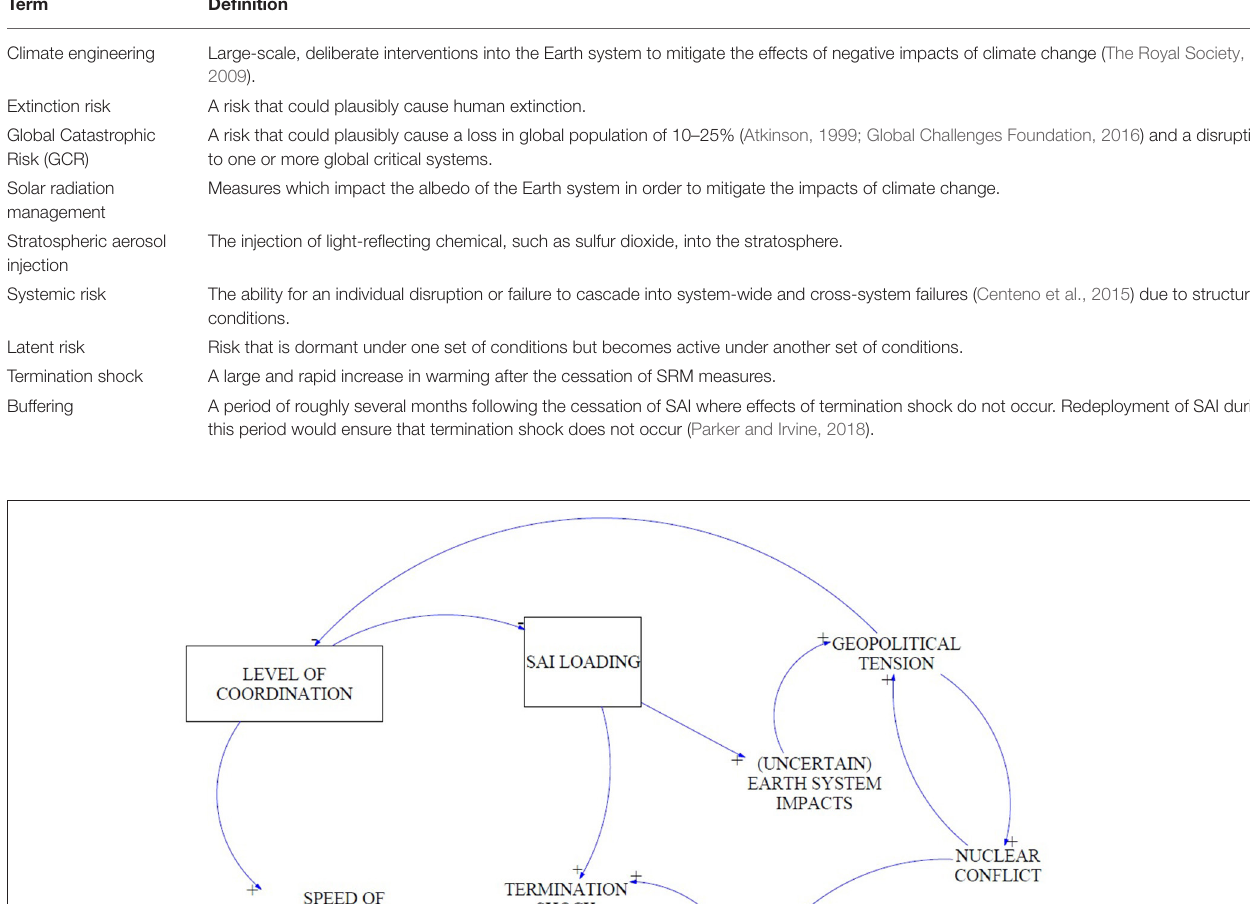
TABLE 1 | Definitions. Term Definition Climate engineering